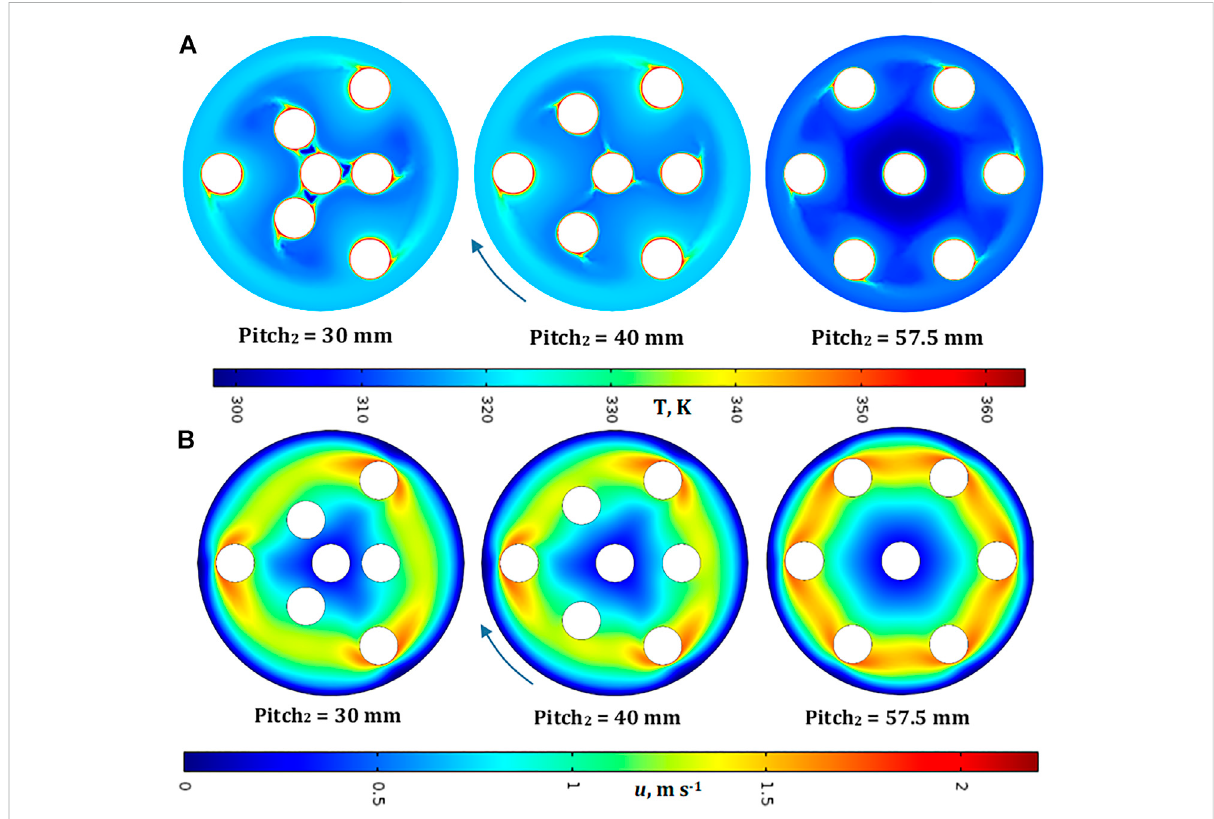
FIGURE 9 (A) Temperature and (B) velocity pro fi les at 5 s for different pitch 2 values in adiabatic conditionsin alternate con fi guration. Fluid: water, viscosity = 1,000